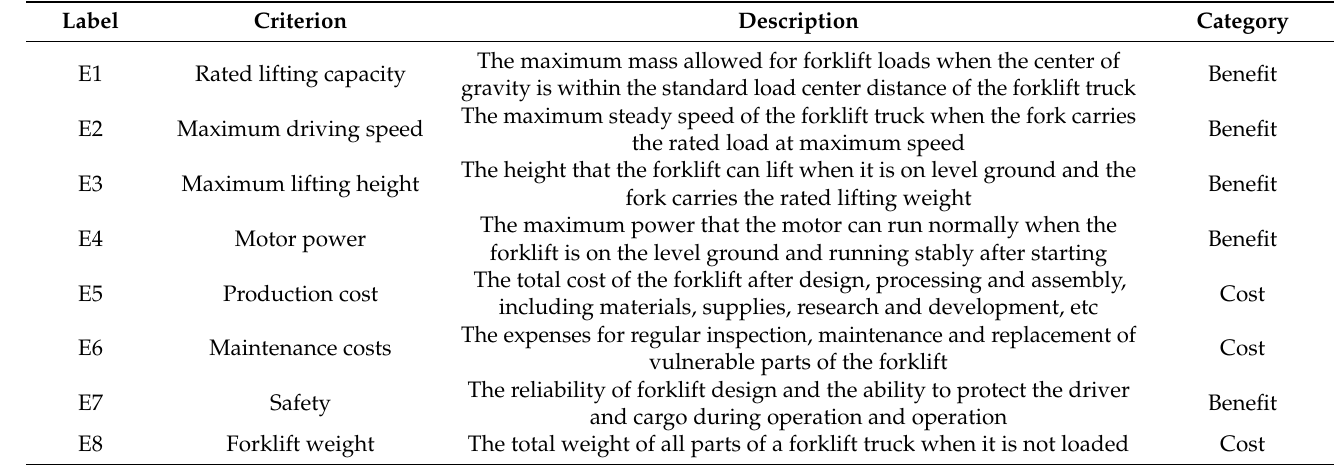
Table 6. Description of evaluation criteria in the economic objective of warehouse logistics